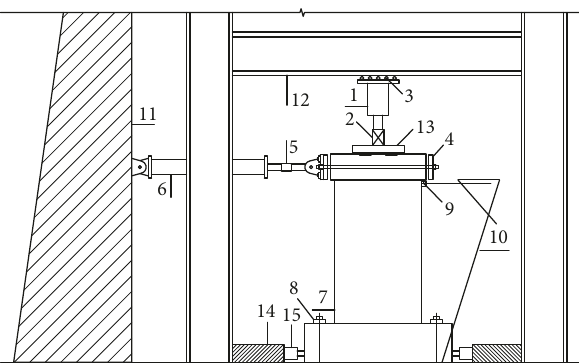
Figure 3: Loading device: 1, 150T vertical oil jack; 2, 150T vertical sensor; 3, sliding support; 4, horizontal connection device; 5, 150T horizontal sensor; 6, 150T horizontal actuator; 7, test piece; 8, anchro bolt; 9, displacement meter; 10, slotted-angle shelving; 11, reaction wall; 12, reaction beam; 13, distribution beam; 14, support; 15, 30T